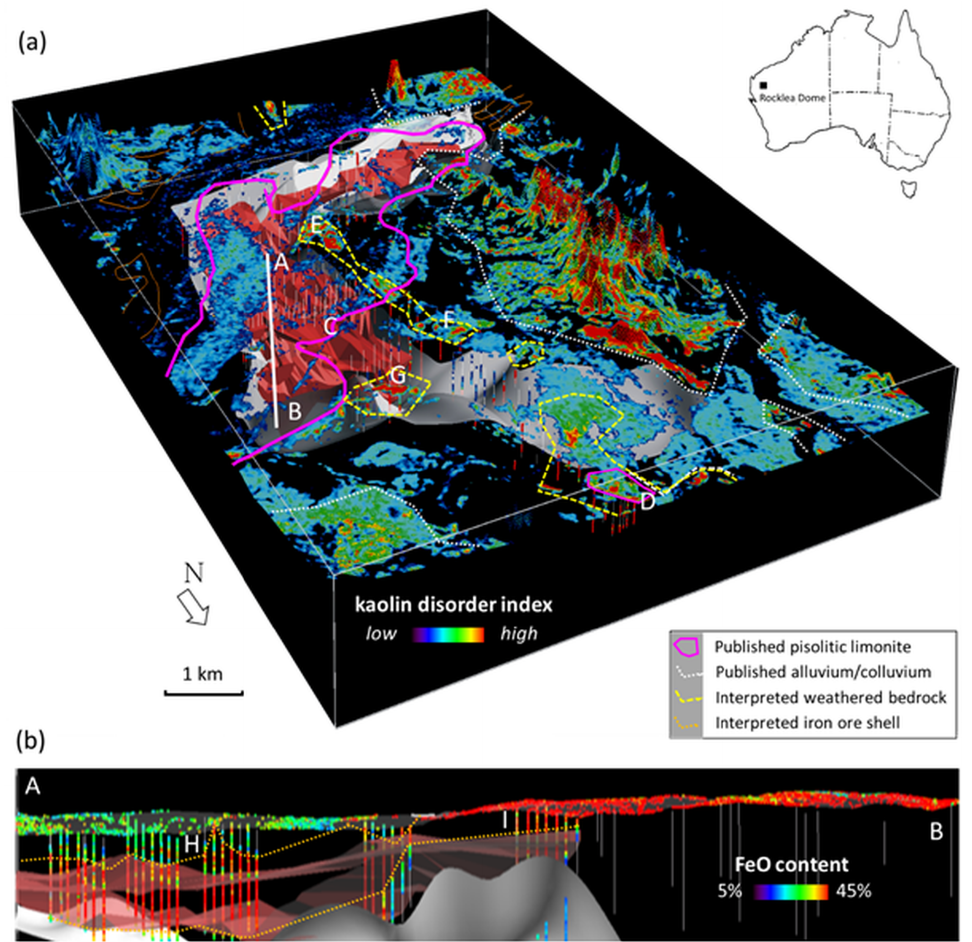
Figure 4. 3D mineral models of the Rocklea Dome area (Cudahy, 2016). Scene centre is approximately lat 22.8216 ◦ , long 117.4652 ◦ . (a) A southwest oblique 3D view of the Rocklea Dome study area showing kaolin disorder measured using airborne HyMap™ (surface) and drill core HyLogger™ (coloured vertical pegs) reflectance spectra. Warmer colours (well-ordered kaolin) relate to weathered, in situ bedrock, while cooler colours (poorly ordered kaolin) relate to transported (alluvium/colluvium) materials. The interpolated model of the base of the channel iron system calculated using the 3D kaolin crystallinity map is shown by the shaded grey surface. The CID, which was calculated from the XRF-derived weight percent FeO (Haest et al., 2012a), is shown by a shaded red volume (C). Areas of weathered bedrock (Haest et al., 2012b; Cudahy, 2016) are highlighted by yellow-coloured hashed lines and highlight which drill cores were sunk into barren ground (D, E, F, G). A straight white line shows the location of the cross section (A–B) presented in panel (b) . (b) Cross section A–B in panel (a) of the % FeO measured from the drill core and airborne imagery, which was vegetation unmixed (Haest et al., 2013). Dotted orange polygon indicates the shell of iron ore, which extends from under cover of ∼ 20m of alluvium (H) to exposed at the surface